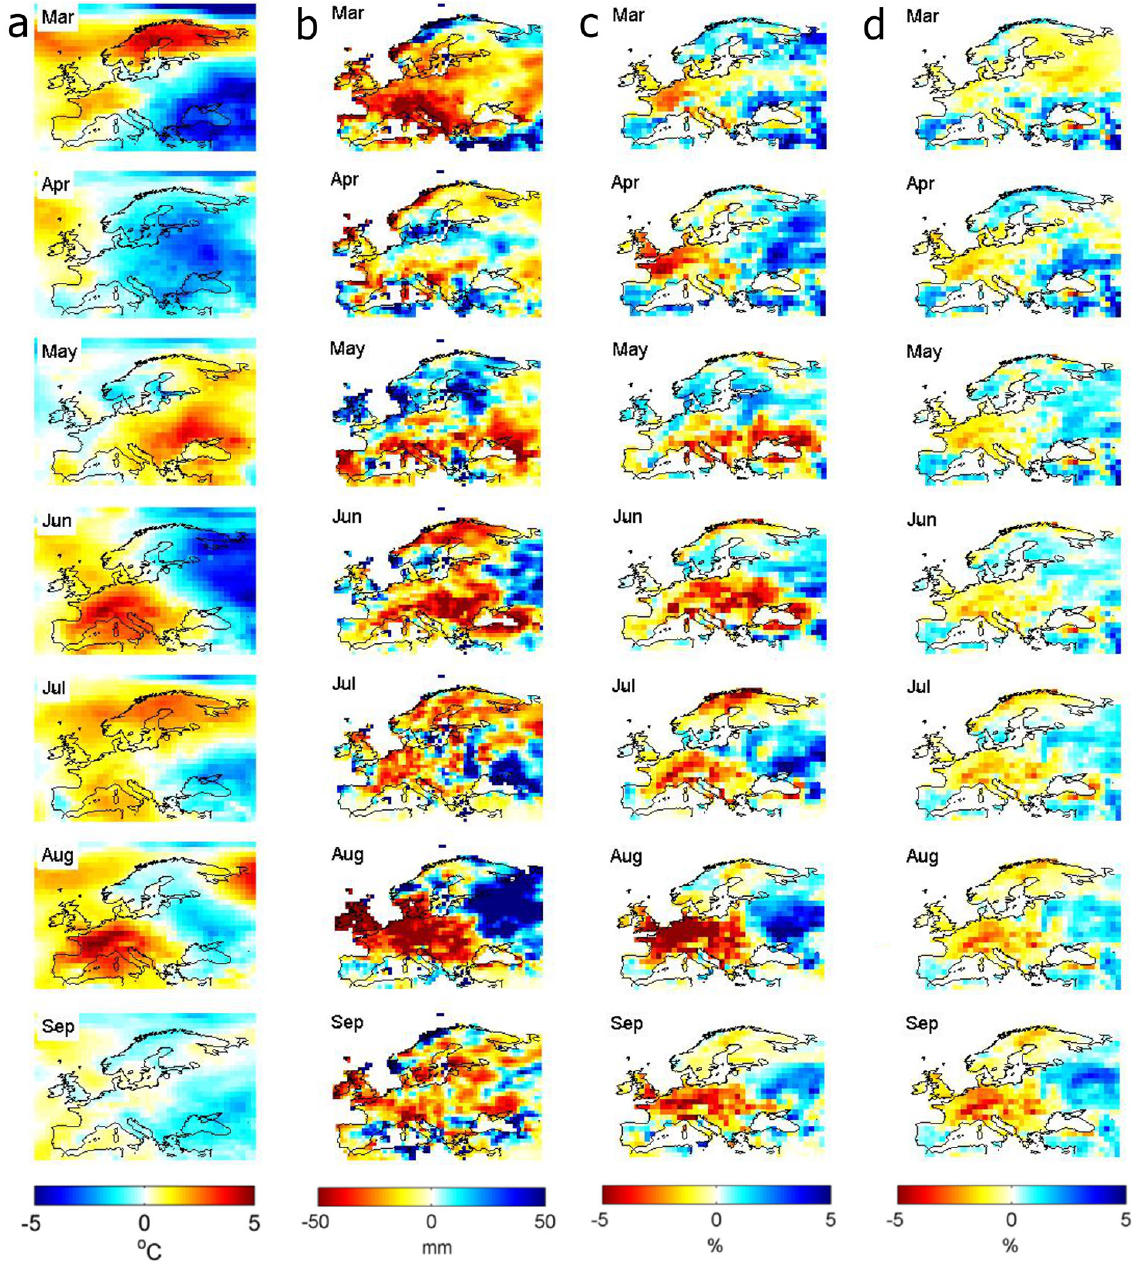
Figure 7. Monthly climate anomalies over Europe during spring and summer 2003: (a) average temperature at 2m ( T anom ); (b) precipitation ( P anom ); (c) volumetric soil water at level 1, 0–7cm (SW1 anom ); and (d) volumetric soil water at level 4, 100–289cm (SW4 anom ). T anom , SW1 anom and SW4 anom fields from the ERA-Interim Reanalysis and P anom from GPCC, based in near-real time rain gauge